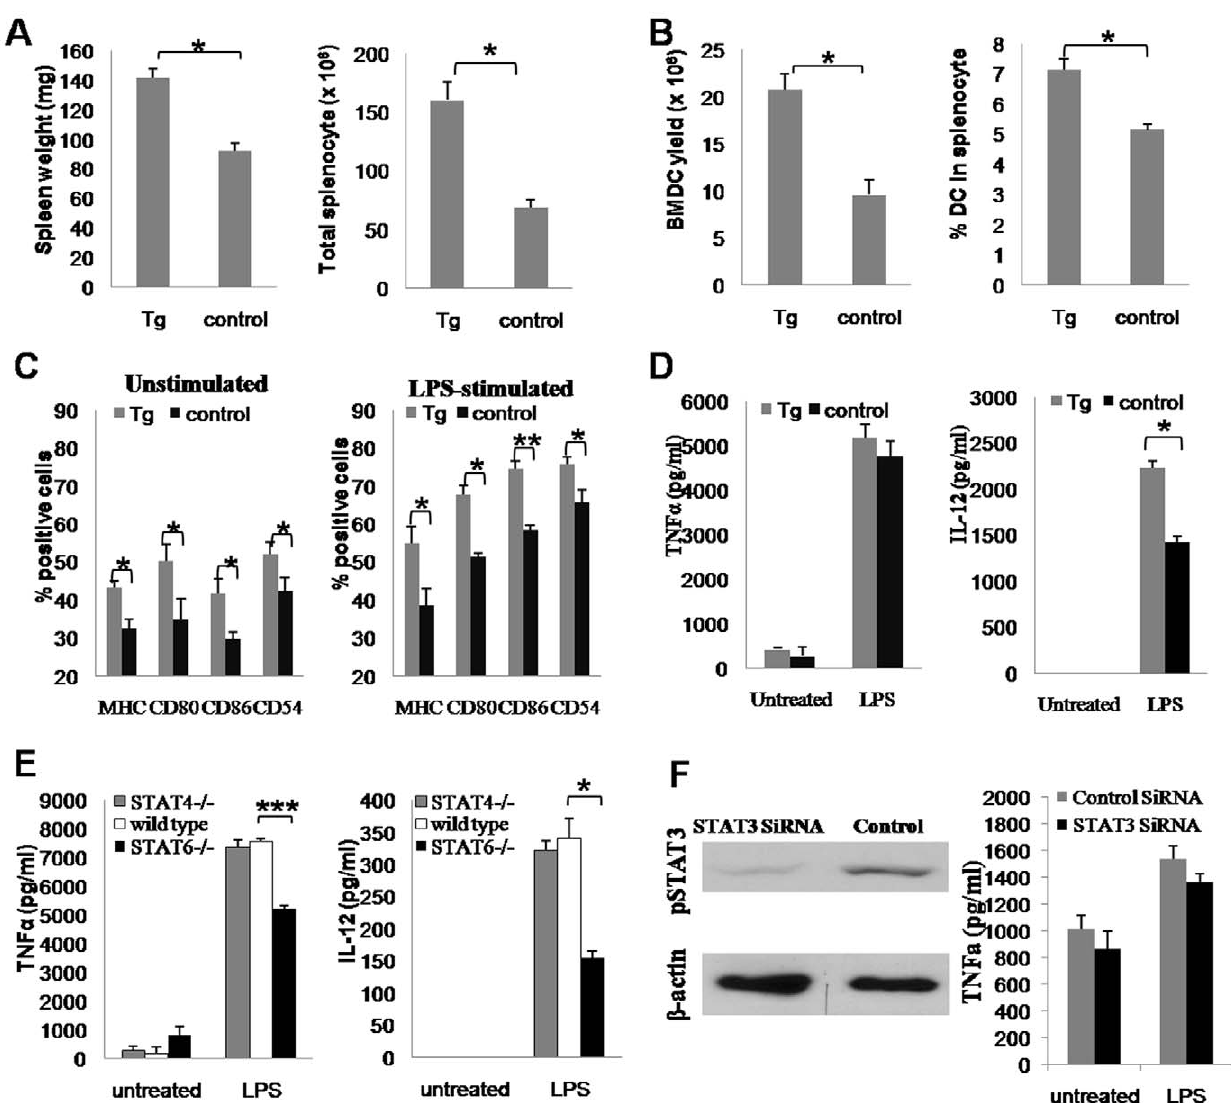
Figure 6. Jak2/STAT5 signaling is indispensable for DC development and maturation, while the capacity of DC for secretion of proinflammatory cytokines is regulated by both Jak2/STAT5 and Jak2/STAT6 signaling. (A) Stat5-Tg mice show larger size for the spleen and higher number of splenocytes. (B) Transgenic Stat5 expression enhances BMDC yield and increases the percentage of splenic DCs in total splenocytes (C) DCs with transgenic Stat5 expression show higher potency in response to LPS stimulation. Significant higher percentage of DCs show matured phenotype as characterized by high levels of MHC II and costimulatory molecule expressions before/after LPS stimulation. (D) ELISA analysis of cytokines secreted by DCs with transgenic Stat5 expression. Stat5-Tg BMDCs showed similar capacity for secretion of TNF a , while the production of IL-12 was significantly higher than that of control BMDCs after LPS stimulation. (E) ELISA analysis of cytokine secretion by BMDCs generated from Stat4 2 / 2 and Stat6 2 / 2 mice. Stat6 2 / 2 BMDCs showed significant lower capacity for secretion of TNF a and IL-12 upon LPS stimulation. In contrast, Stat4 2 / 2 BMDCs showed similar capacity for secretion of above indicated cytokines as control BMDCs. (F) Down-regulation of Stat3 in DC2.4 cell by siRNA. DC2.4 cells were first transfected with a Stat3 -specific siRNA or a scramble RNA followed by LPS stimulation for analysis of cytokine secretion. Left panel: Western blot results showing significant down-regulation of pSTAT3 in cells transfected with siRNA. Right panel: ELISA analysis of cytokine secretion. IL-12 was undetectable in both siRNA and scramble transfected DC2.4 cells, while siRNA transfected DC2.4 cells showed similar capacity for secretion of TNF a . Data shown in the figure are presented as mean 6 SE. *, p , 0.05; **, p , 0.01; ***, p , 0.001.